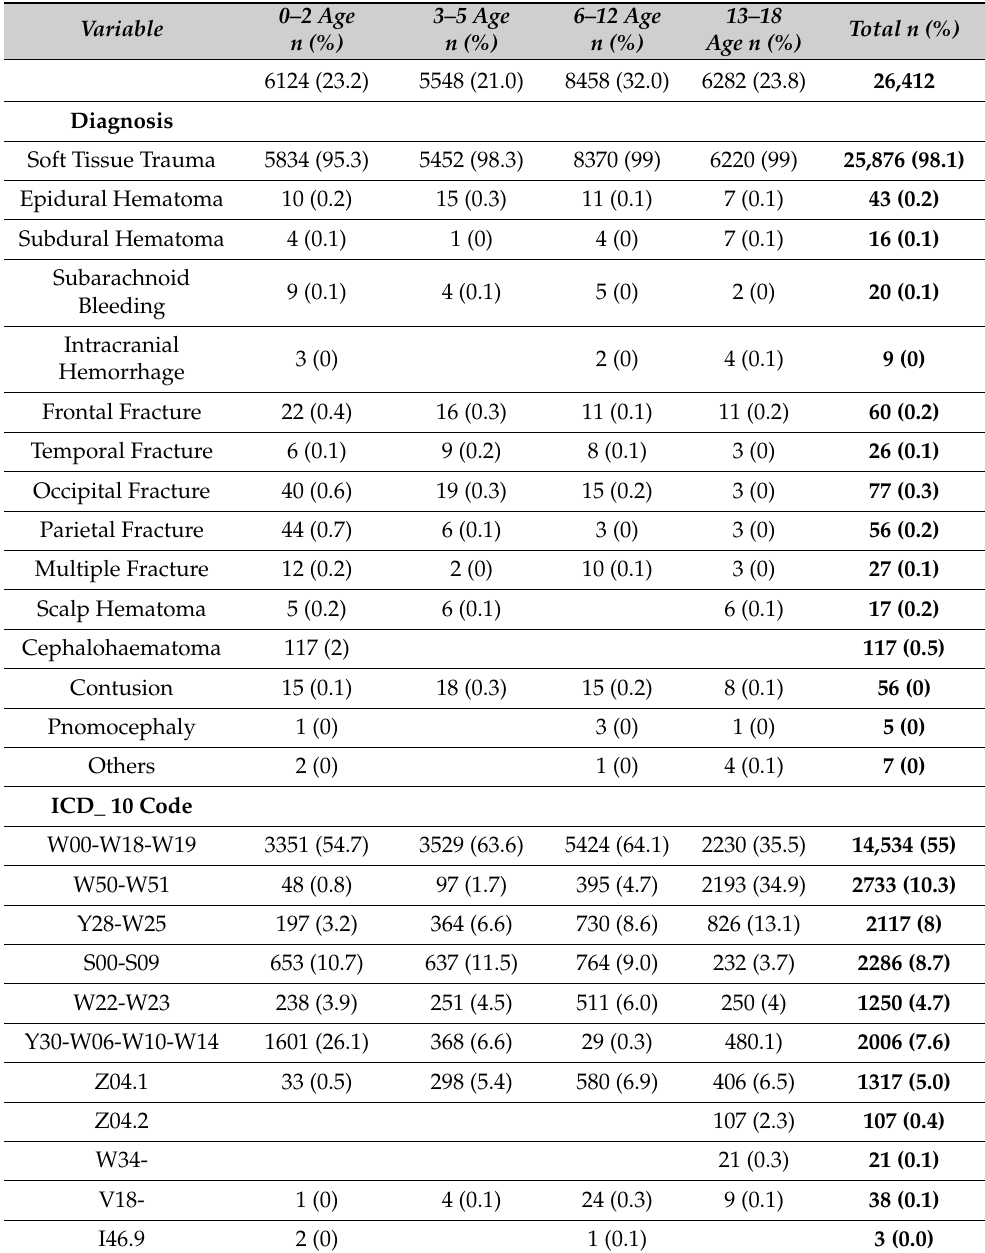
Table 2. ICD 10 code and cranial CT diagnoses of the patients according to child age